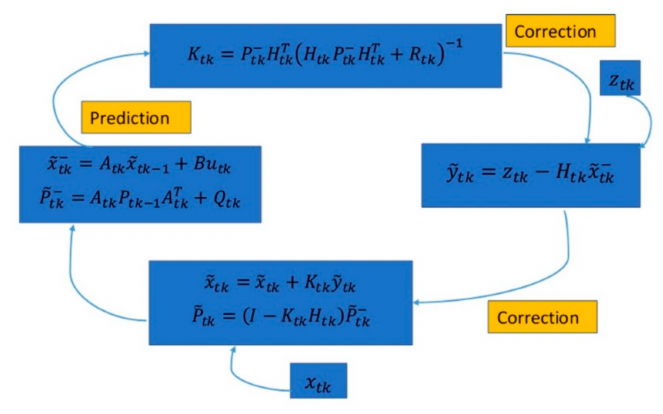
Figure 1. Kalman’s filter